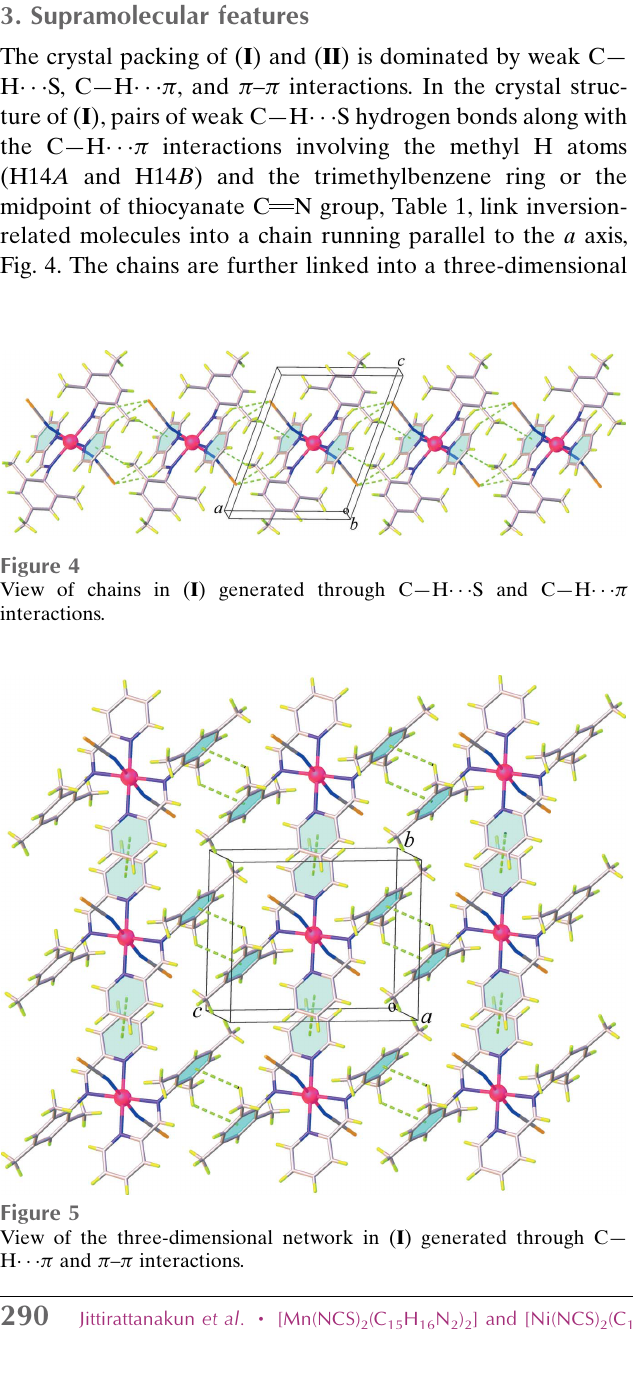
supramolecular network through weak (cid:2) – (cid:2) interactions involving the pyridine rings [centroid-to-centroid distance =